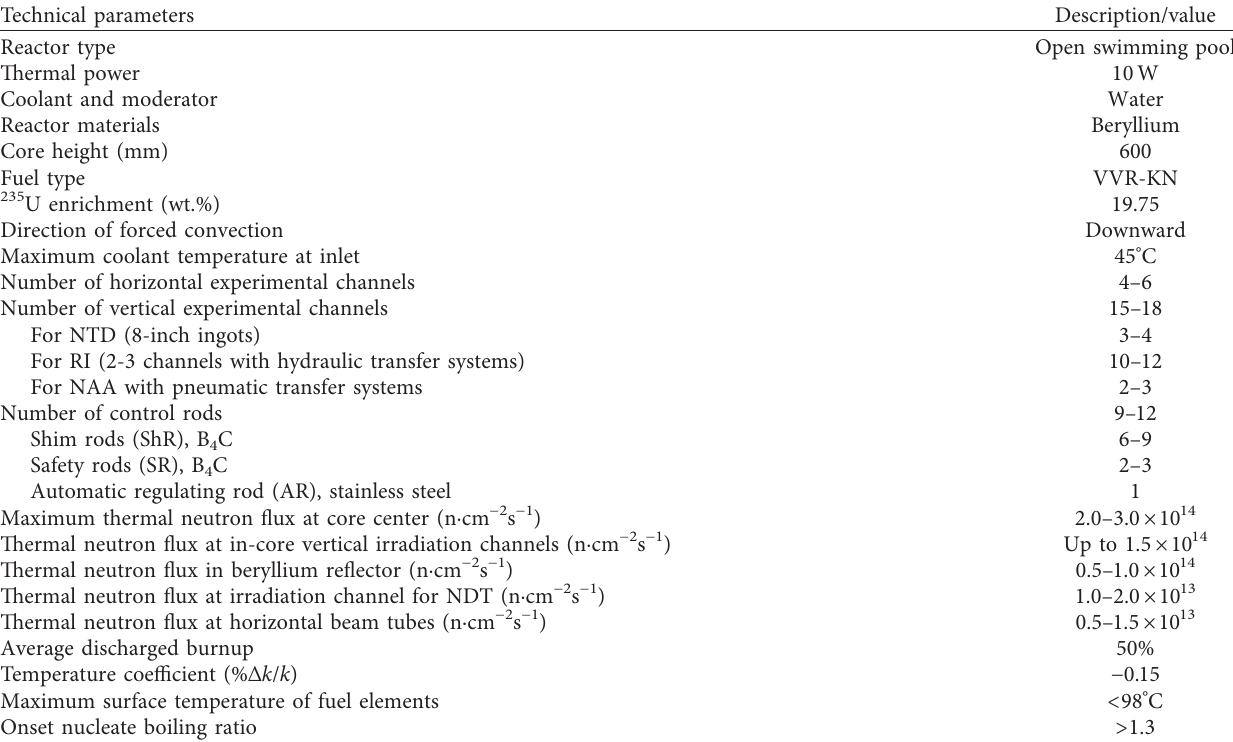
Table 1: Main design parameters and design targets of the MPRR